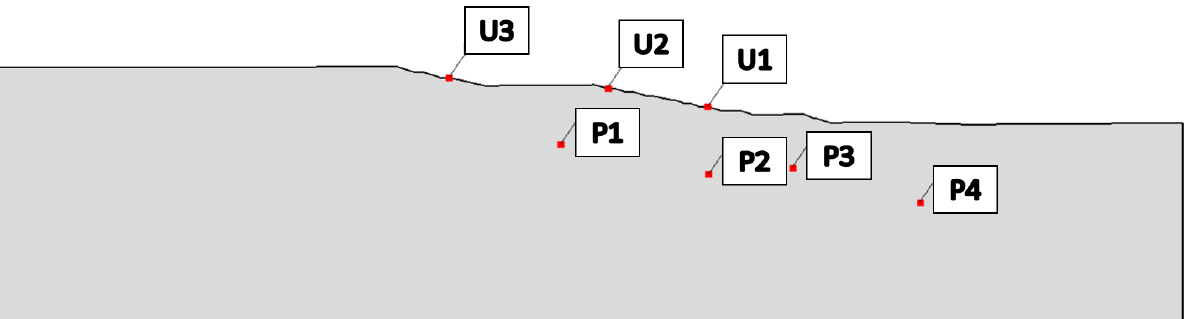
Figure 6: Geometry and mesh of numerical model at computational step